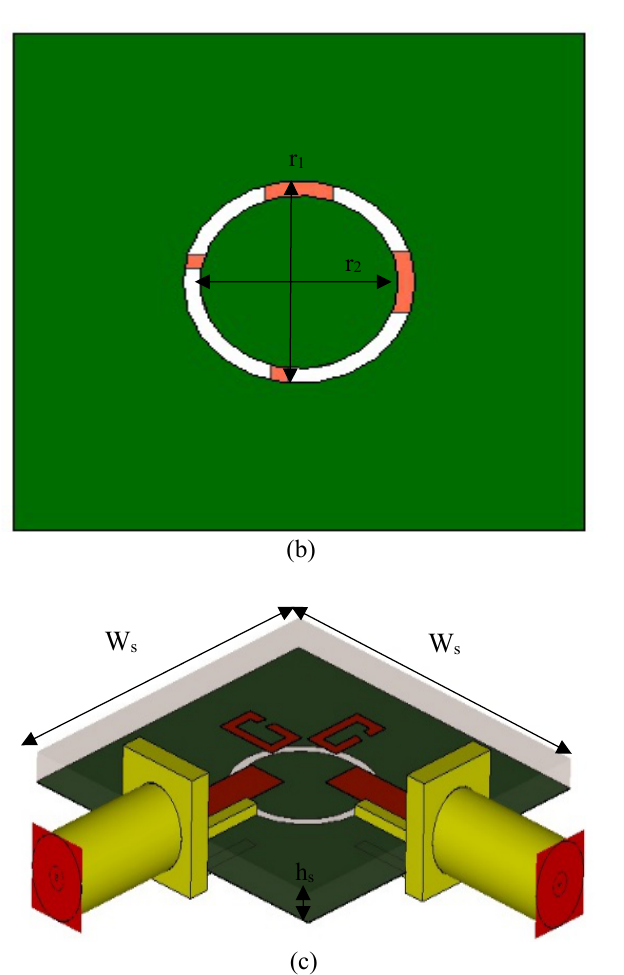
FIGURE 1: Single antenna, (a) top view, (b) bottom view, and (c) side view.